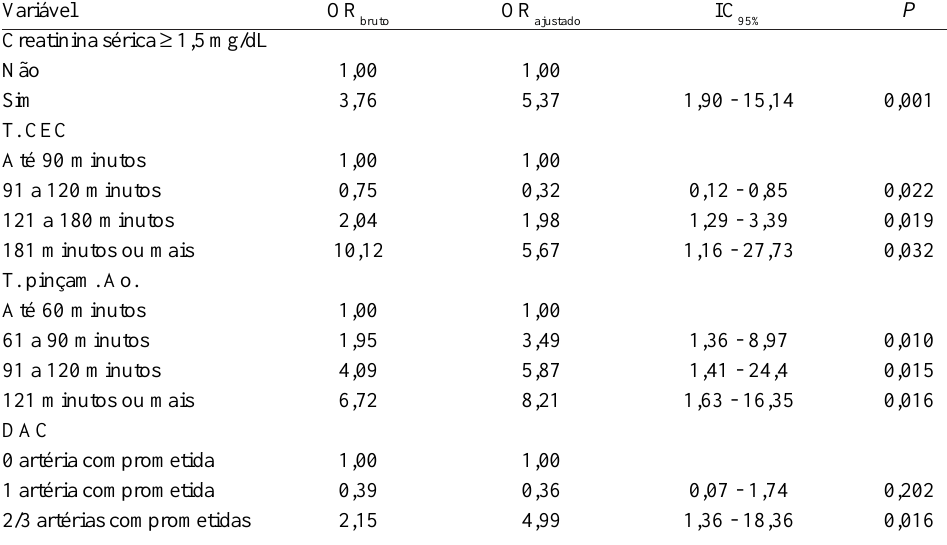
Tabela 5. Resultado do modelo de regressão logística do